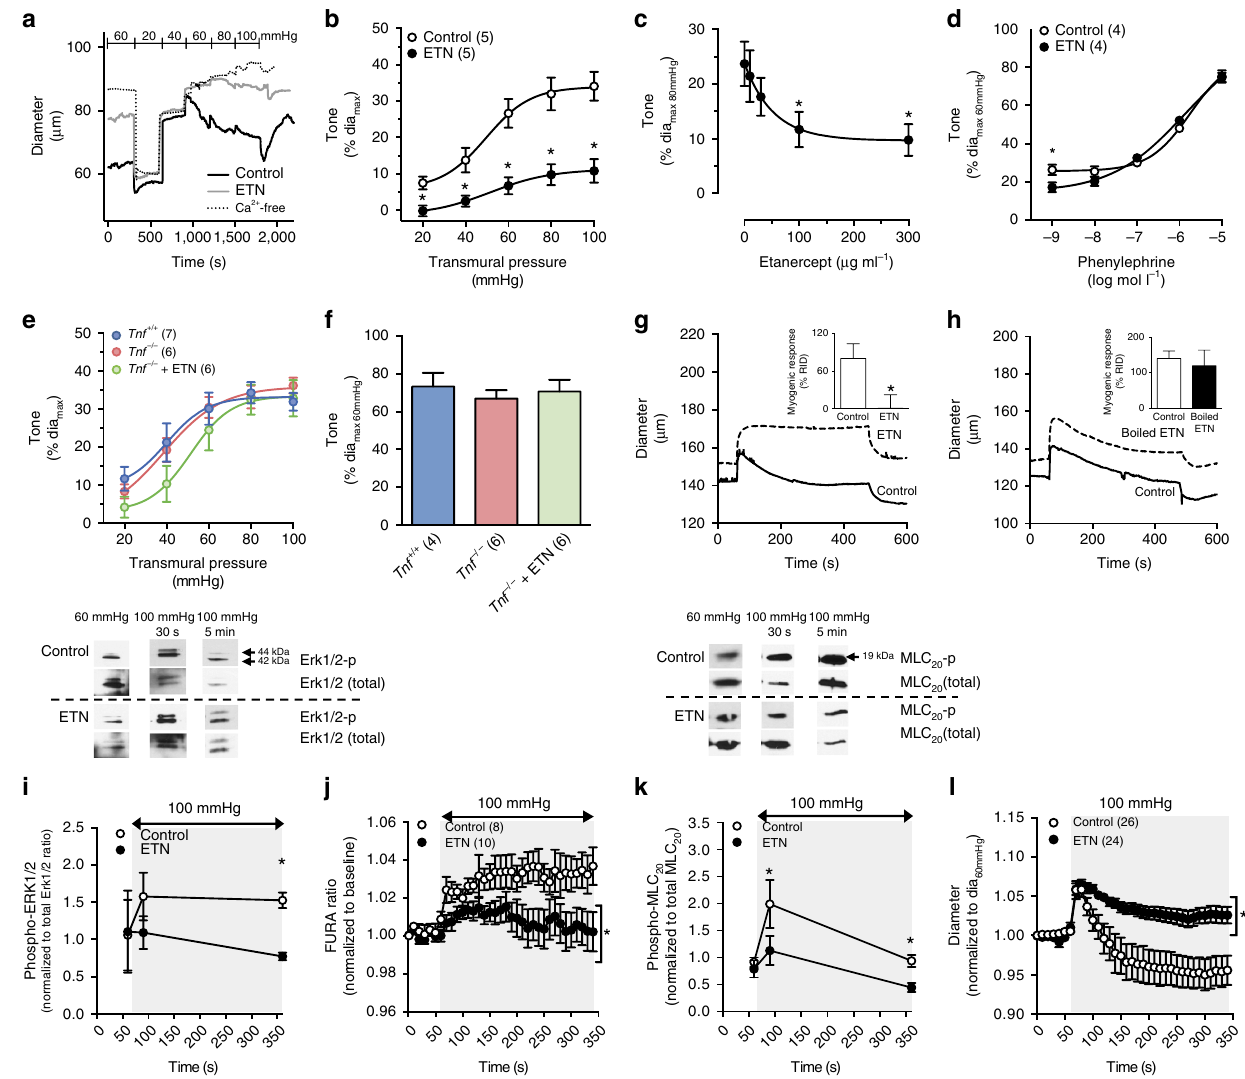
Figure 4 | Acute TNF scavenging attenuates myogenic vasoconstriction. ( a ) Representative traces of myogenic vasoconstriction in mouse cremaster arteries in the presence of ETN (300 m gml (cid:2) 1 in vitro ) and ( b ) statistical comparison. ( c ) Dose-dependency of ETN’s effect at 80mmHg ( n ¼ 5 arteries at 0, 7 at 10, 6 at 30, 6 at 100 and 5 at 300 m gml (cid:2) 1 ). ( d ) Phenylephrine-stimulated vasoconstriction (ETN, 300 m gml (cid:2) 1 ). ( e ) Myogenic and ( f ) 10 m moll (cid:2) 1 phenylephrine-stimulated vasoconstriction in cremaster arteries from Tnf þ / þ and Tnf (cid:2) / (cid:2) with and without ETN (300 m gml (cid:2) 1 ). ( g , h ) Representative traces shown of myogenic vasoconstriction (45–100mmHg pressure step) in hamster gracilis arteries with ( g ) native ETN (10 m gml (cid:2) 1 ; inset: comparison in n ¼ 6 arteries per group) and ( h ) heat-denatured ETN (10 m gml (cid:2) 1 ; inset: comparison in n ¼ 6 arteries per group). Myogenic responses displayed as reversal of initial distension (RID). ( i ) Western blot assessments of ERK1/2 phosphorylation (60–100mmHg pressure step; control: n ¼ 4 at 60, 5 at 90 and 4 at 360s; ETN: n ¼ 3 at 60, 5 at 90 and 4 at 360s). Representative images above and uncropped images in Supplementary Fig. 3a–h. ( j ) Intracellular Ca 2 þ (60–100mmHg pressure step). ( k ) Western blot assessments of MLC 20 phosphorylation (60–100mmHg pressure step; control: n ¼ 11 at 60, 6 at 90 and 7 at 360s; ETN: n ¼ 4 at 60, 6 at 90, and 5 at 360s). Representative images above and uncropped images in Supplementary Fig. 3i–n. ( l ) Myogenic response (60–100mmHg pressure step; normalized to 10s average baseline diameter; control: 62 ± 2, ETN: 68 ± 2 m m). Shading denotes 100mmHg. Parentheses indicate number of arteries per group. Data are mean ± s.e.m.; * P o 0.05 in Student’s unpaired t- test ( b , d , i – l ), in Dunnett’s post hoc comparison to concentration 0 following a one-way ANOVA ( c ), and Student’s paired t- test ( g , h , insets). In ( e , f ), the one-way ANOVAs are nonsignificant. ANOVA, analysis of